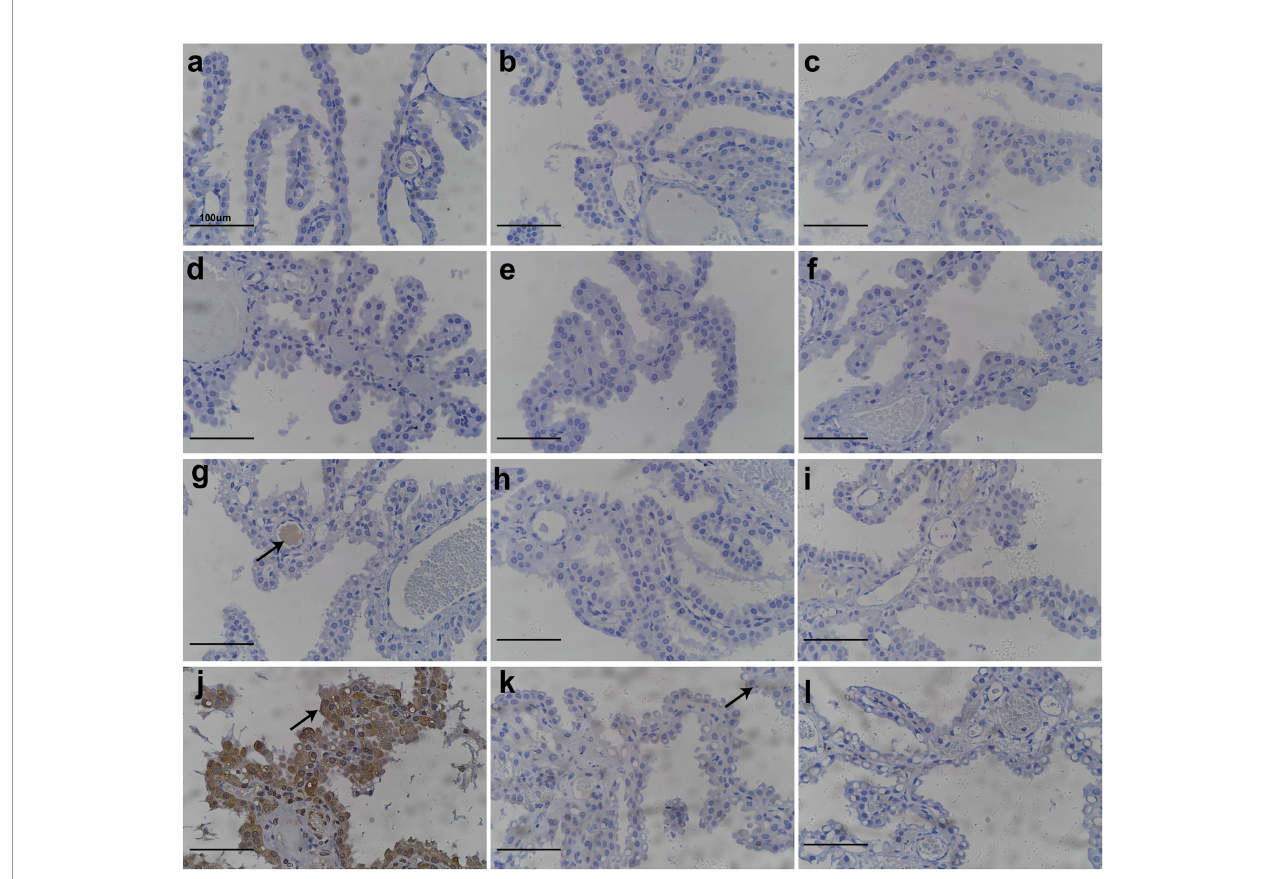
FIGURE 4 | Anti-PEG IHC staining of cynomolgus monkeys CP epithelium with 52-week administration of Jintrolong and after 104-/157- week recovery. (A) Excipient control group. (B) Excipient control group after 104-week recovery. (C) Excipient control group after 157-week recovery. (D – F) 0.3 mg/kg/week Jintrolong group at 52-week, after 104-week recovery, after 157-week recovery, respectively. (G – I) 1 mg/kg/week Jintrolong group at 52-week, after 104-week recovery, after 157-week recovery, respectively. (J – L) 3 mg/kg/week Jintrolong group at 52-week, after 104-week recovery, after 157-week recovery, respectively. Arrow in panel (G) indicates anti-PEG staining in vessel. Arrow in panel (J) indicates representative anti-PEG staining in CP epithelium. Arrow in panel (K) indicate weak anti-PEG staining in recovery